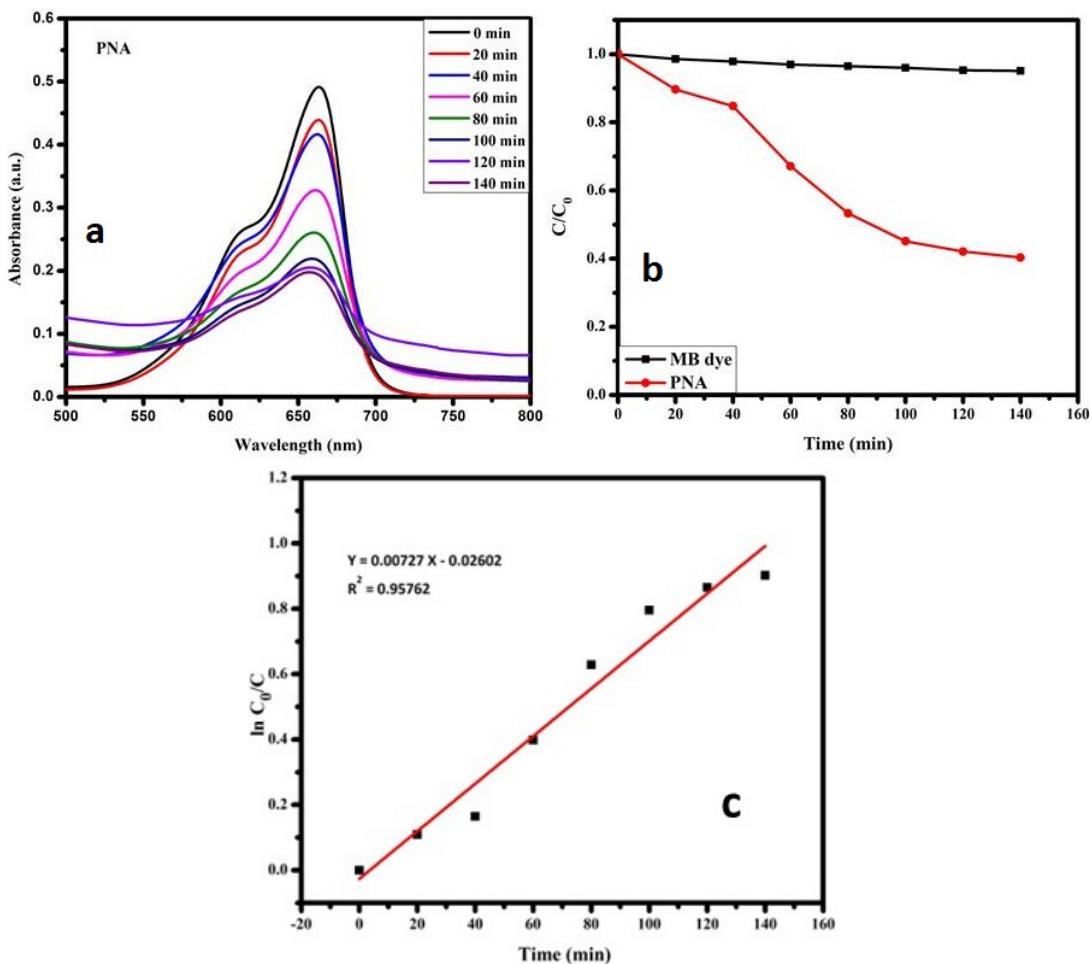
Figure 7. ( a ) Photocatalytic degradation and ( b ) degradation efficiency of PNA against MB dye; ( c ) first-order kinetics graph of MB dye photodegradation reaction.